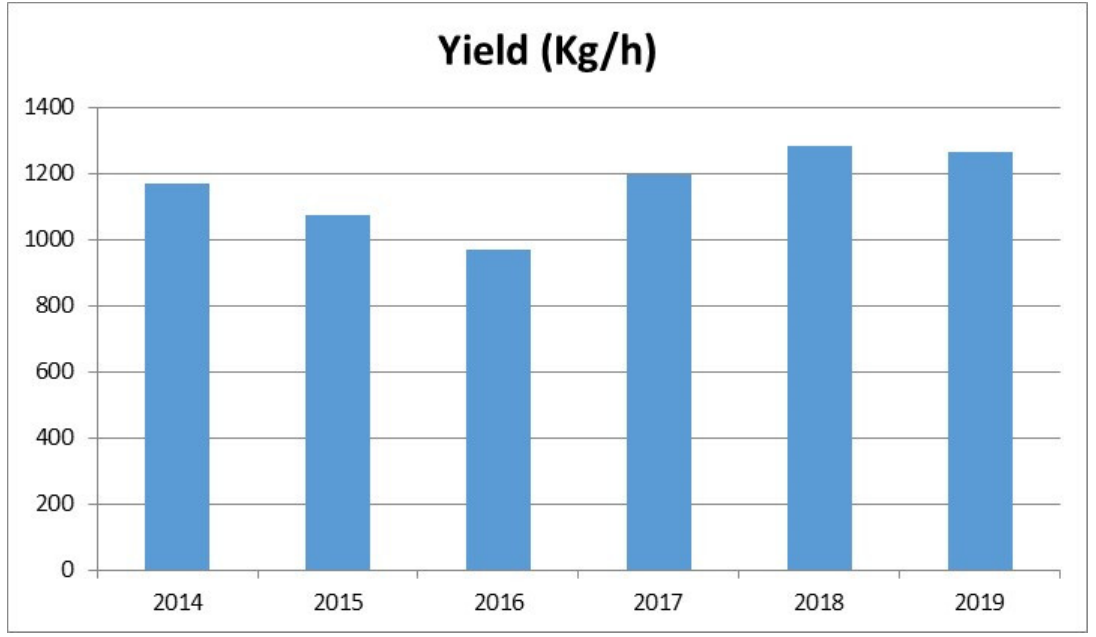
Figure 2. Annual yield (per hectare) of oilseeds in India (adapted from Statista Research Depart- ment, https://fr.statista.com/a-propos/notre-engagement-pour-la-recherche, Accessed on 16 Octo- ber 2020). Table 2. Nutrient content of oilseeds (100 g) (adapted from Food Standards Agency